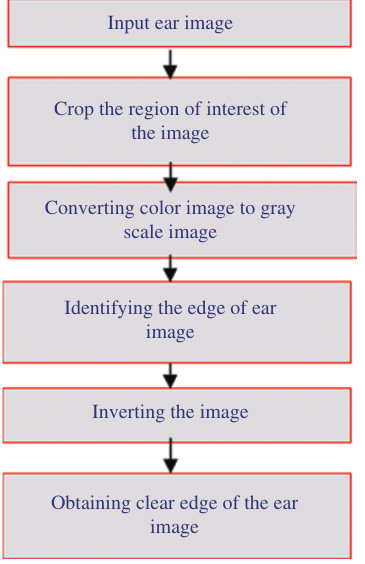
Figure 3: Steps Involved in Ear Edge Extraction.